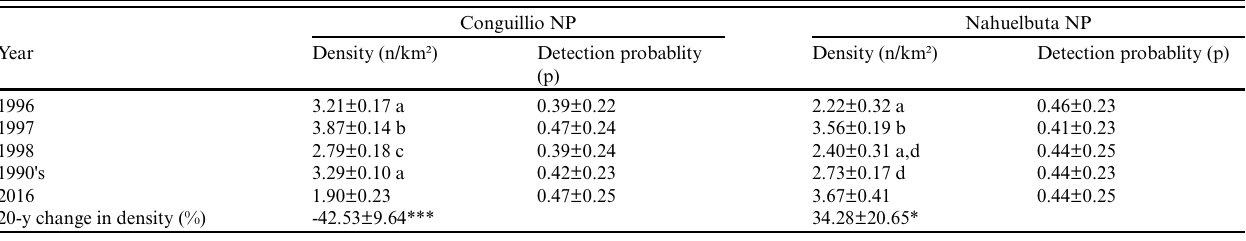
Table 4 . Bayesian estimates of the yearly mean density and detection probability of Magellanic Woodpeckers ( Campephilus magellanicus ; Mean ± SD) for two national parks (NP), as fitted by the best-supported model (Table 2). Different letters indicate significant differences between years for the same park, as evaluated through their Bayesian credible intervals (CI). Bidecadal (1990s vs. 2016) variation (%) in density (± SD) and its p-values are also shown for each park (*p < 0.05; ***p <